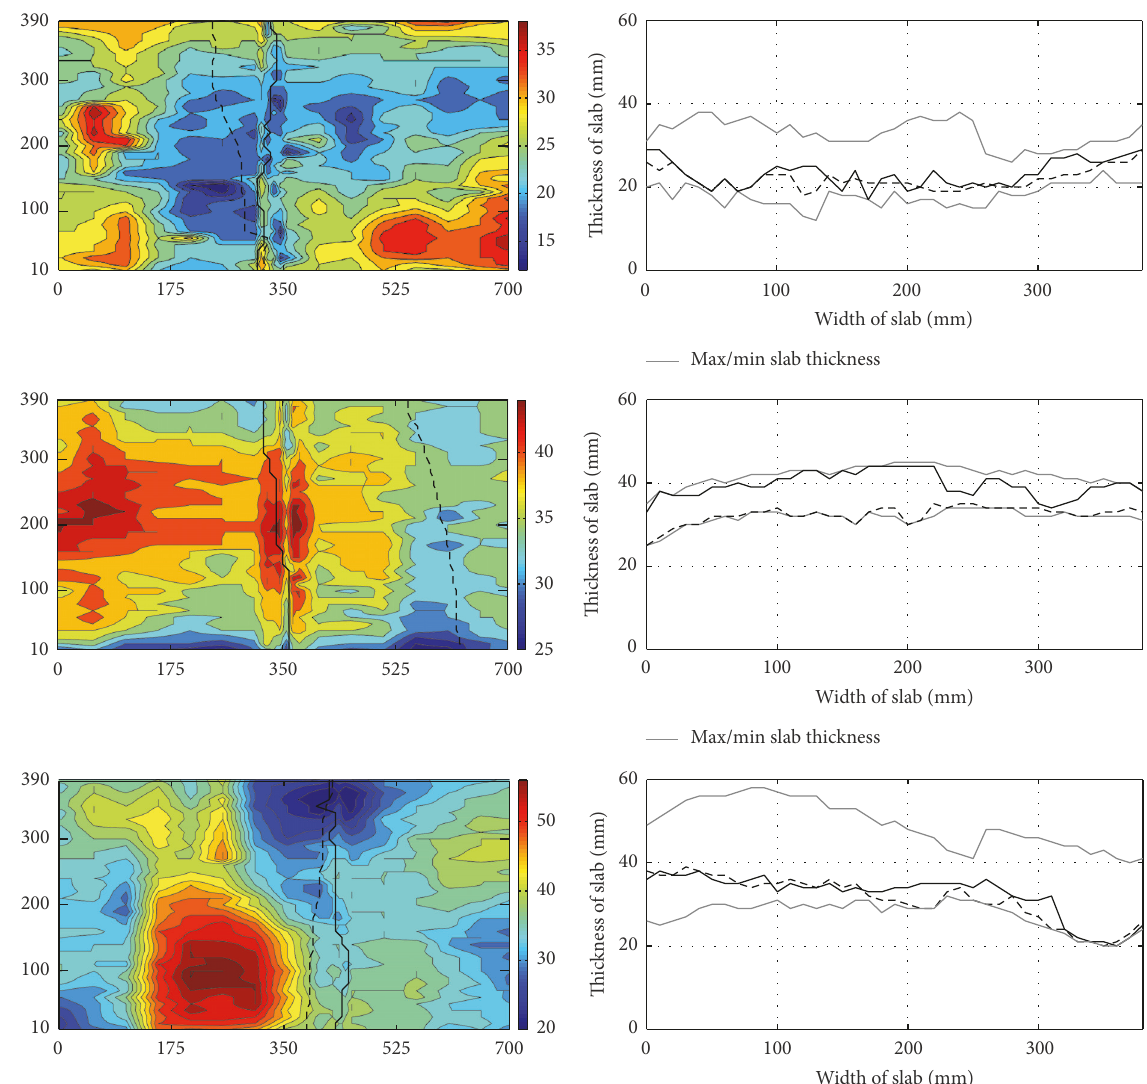
Figure 6: Topographical and sectional plots with crack patterns for end-restrained slabs S1, S4, and S5 (top to bottom). Solid lines show experimental results from [15] and dashed lines numerical result. All measurements in